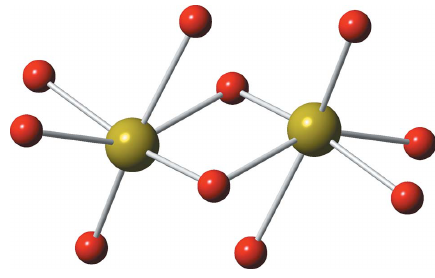
Figure 3 Cationic Na 2 ( (cid:2) -H 2 O) 22+ cluster in the title compound.